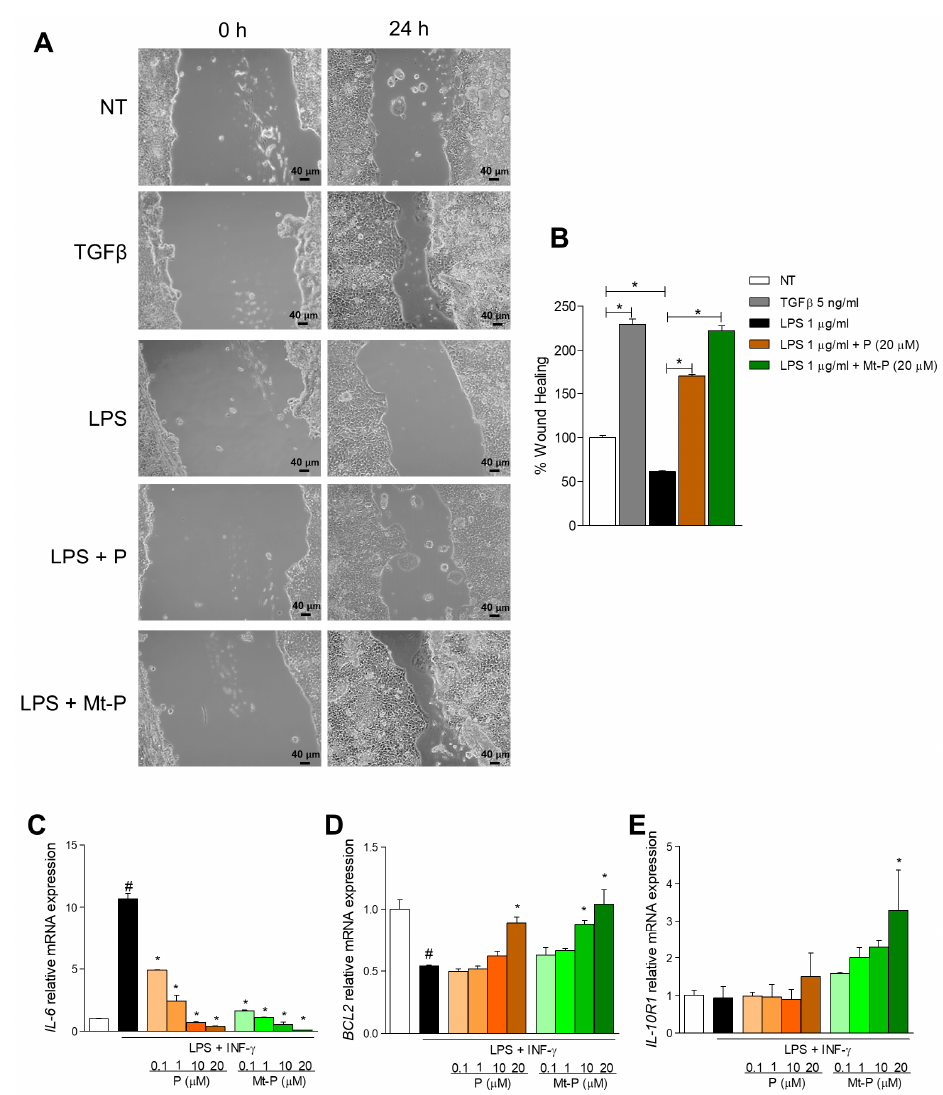
Figure 3. P and Mt-P accelerates the wound healing in Caco-2 cells, reducing inflammation and apoptosis. Confluent Caco-2 cell monolayers were wounded with a pipette tip and incubated with medium alone (NT), TGF β (5 ng / mL) used as positive control, LPS (1 µ g / mL) alone or in combination with P and Mt-P (20 µ M) for 24 h. ( A ) Representative images of scratched areas at 0 and 24 h (Magnification 10 × ). ( B ) Percentage of wound healing at 24 h after scratch (five wells of three fields each) (NT wells were arbitrarily assigned as 100%). Wound healing was photographed at 0 and 24 h after scratch. Results are expressed as mean ± S.E.M. and analyzed using ANOVA followed by Bonferroni’s test. * p < 0.05 compared to control group. ( C – E ) In vitro e ff ects of P and Mt-P on human intestinal epithelial cell activation. Serum-starved Caco-2 cells were primed 16 h with LPS (5 ng / mL) / IFN- γ (20 ng / mL) alone or in combination with increasing concentration of both P and Mt-P (0.1–20 µ M). At the end of stimulation, the relative mRNA expression of pro-inflammatory gene IL-6 , anti-apoptotic gene BCL-2 , and IL-10R1 , was assessed by Real-Time PCR. Values are normalized relative to GAPDH mRNA and are expressed relative to those of not treated cells (NT), which are arbitrarily set to 1 ( n = 3, # p < 0.05 vs. NT, * p < 0.05 vs. LPS). To gain some mechanistic insights into this model, we assessed the effect of P and Mt-P on the expression of IL-6, BCL2 , and IL-10R1 genes in CaCo2 cells exposed to LPS/IFN-γ, and found that bot agents completely abrogated IL-6 mRNA transcription in a concentration-dependent manner (Figure 3C, # p < 0.05 vs. NT cells, * p < 0.05 vs. LPS/IFN-γ cells). Moreover, Mt-P increased the expression of the anti-apoptotic gene BCL2 (Figure 3D, # p < 0.05 vs. NT cells, * p < 0.05 vs. LPS/IFN-